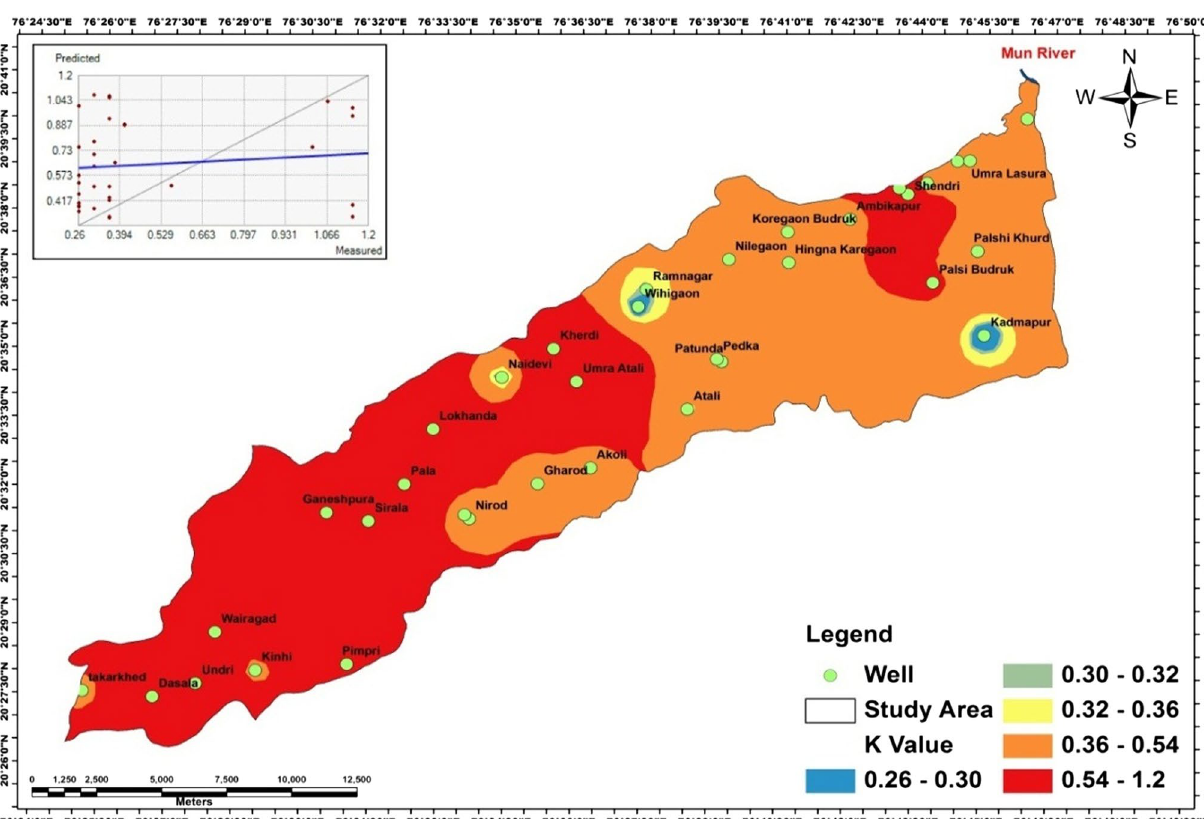
Fig. 10 Spatial distribution map of K 2013